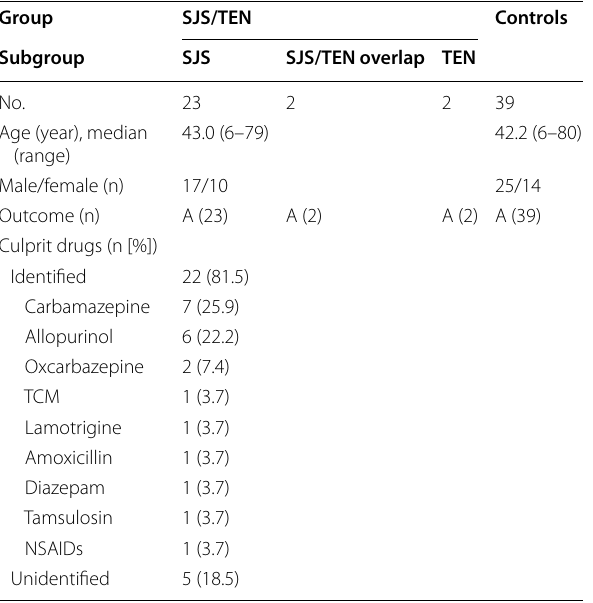
Table 1 Demographic and clinical characteristics